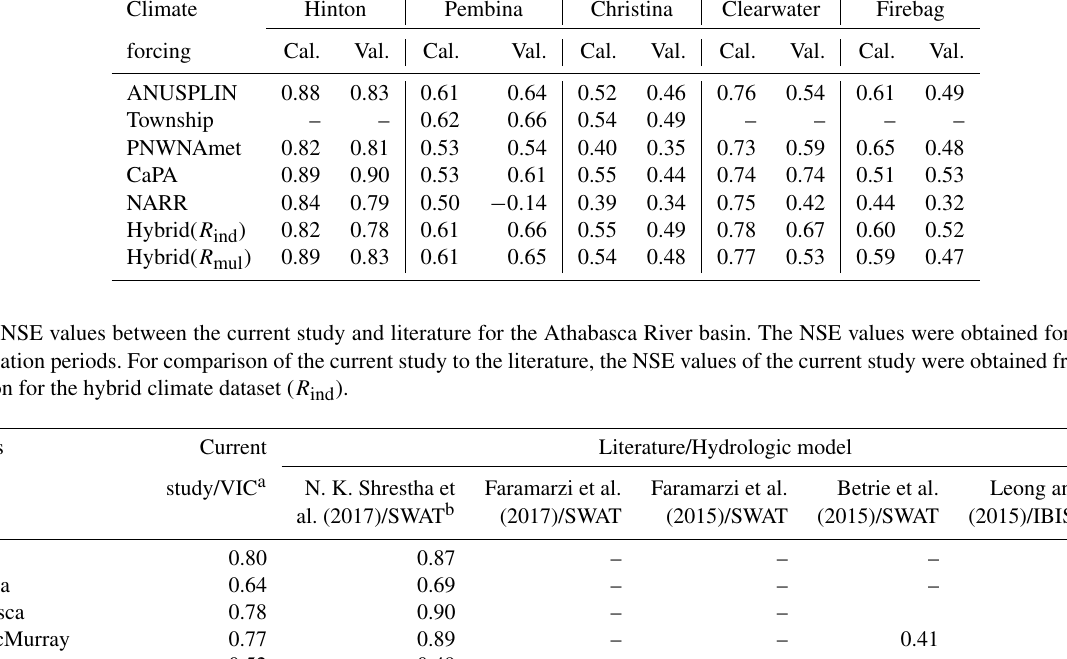
Table 6. Nash–Sutcliffe efficiency (NSE) for the calibration (“Cal.”) and validation (“Val.”) periods at five sub-basins in the ARB for the climate datasets investigated in this study.